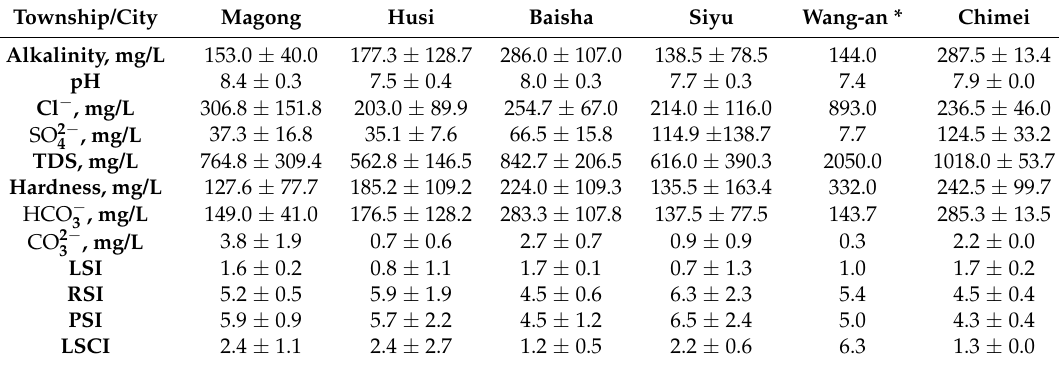
Table 4. Summary of chemical analysis and the water quality index for ground water in Penghu. Township/City